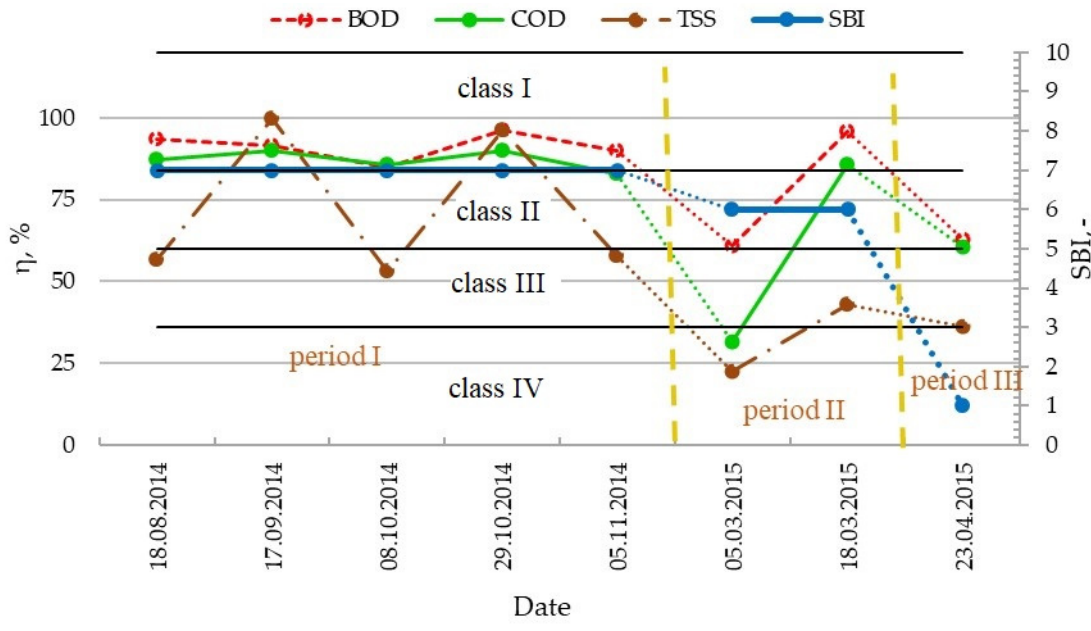
Figure 8. Sludge biotic index (SBI), efficiency of organic compounds (BOD 5 , COD) removal, and efficiency of total suspended solids (TSS) removal in the WTP1.